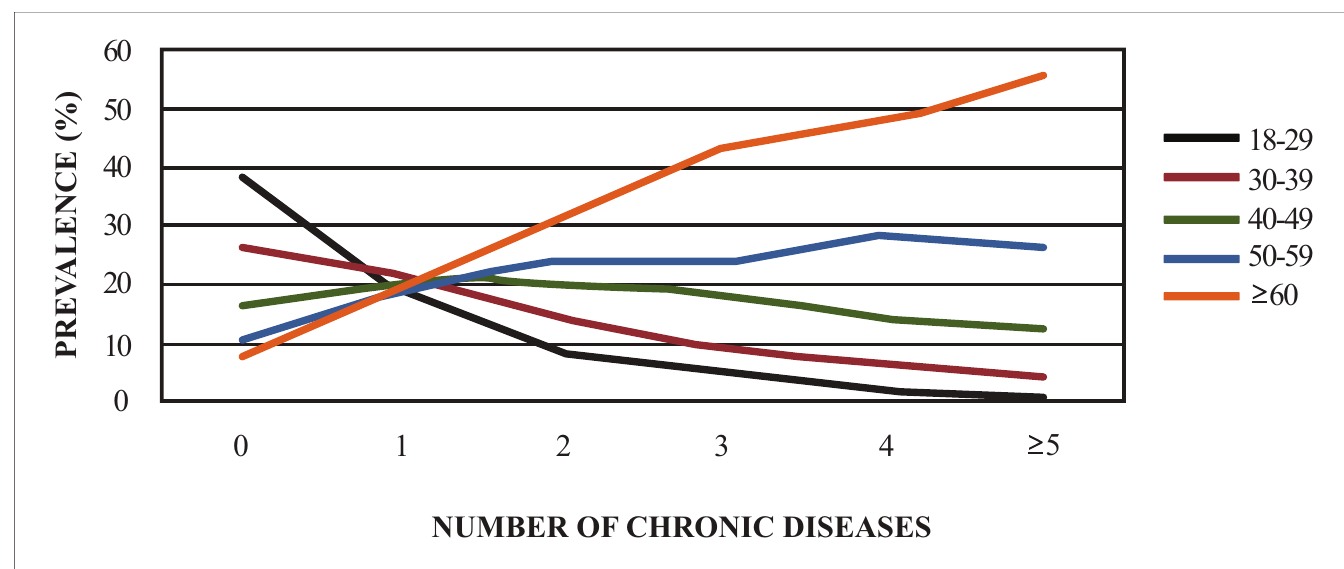
Fig 1. Prevalence (%) of chronic diseasesby age in the adult Brazilian population—NHS, Brazil, 2013.